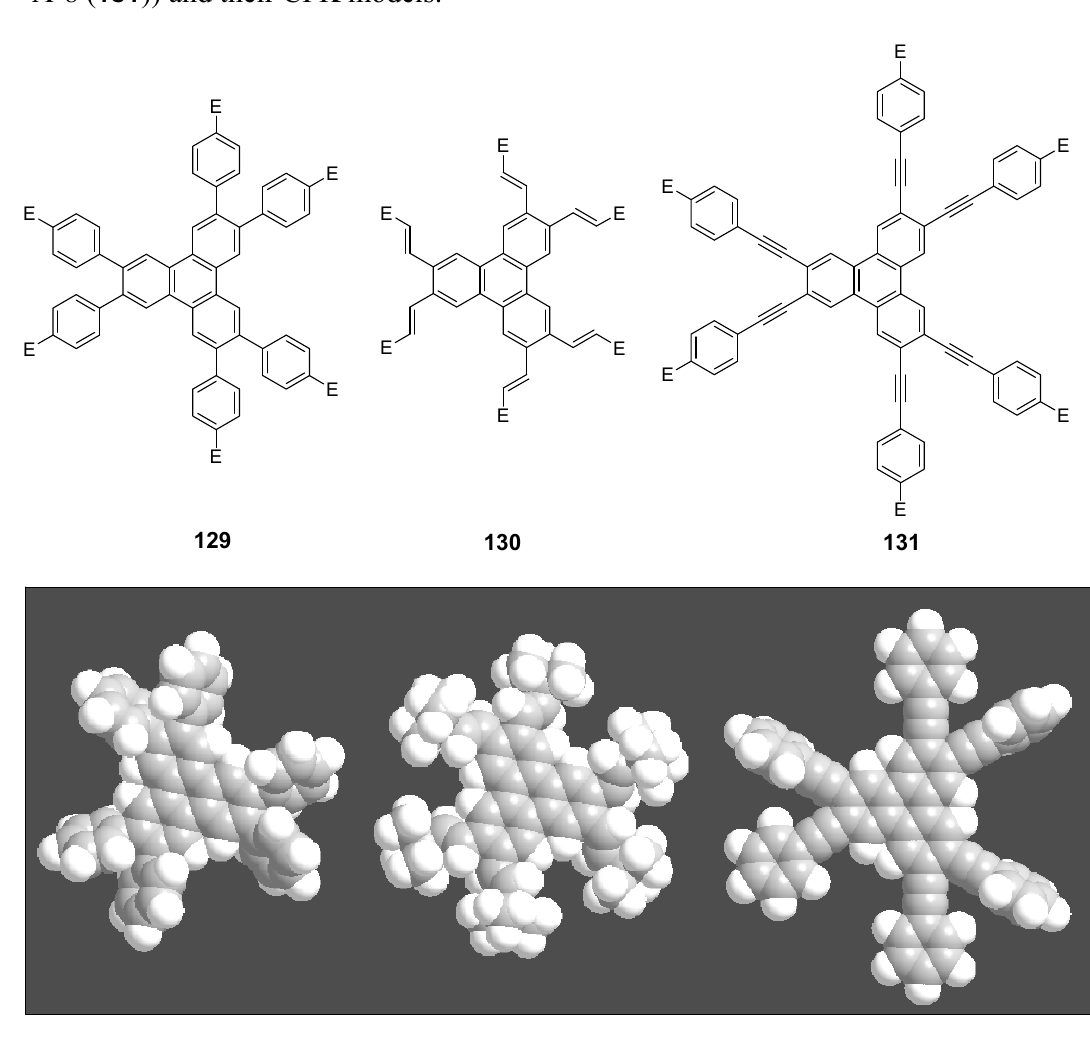
Figure 30. Parent structures of triphenylene stars (C-12-A-3 ( 129 ), C12-A1 ( 130 ), C-12- A-8 ( 131 )) and their CPK